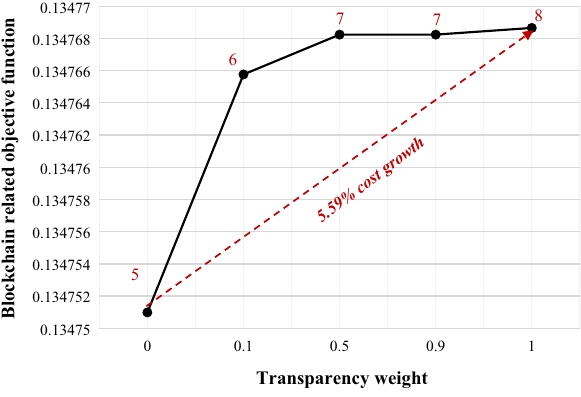
Figure 5. Relationship between cost, transparency and number of blocks.